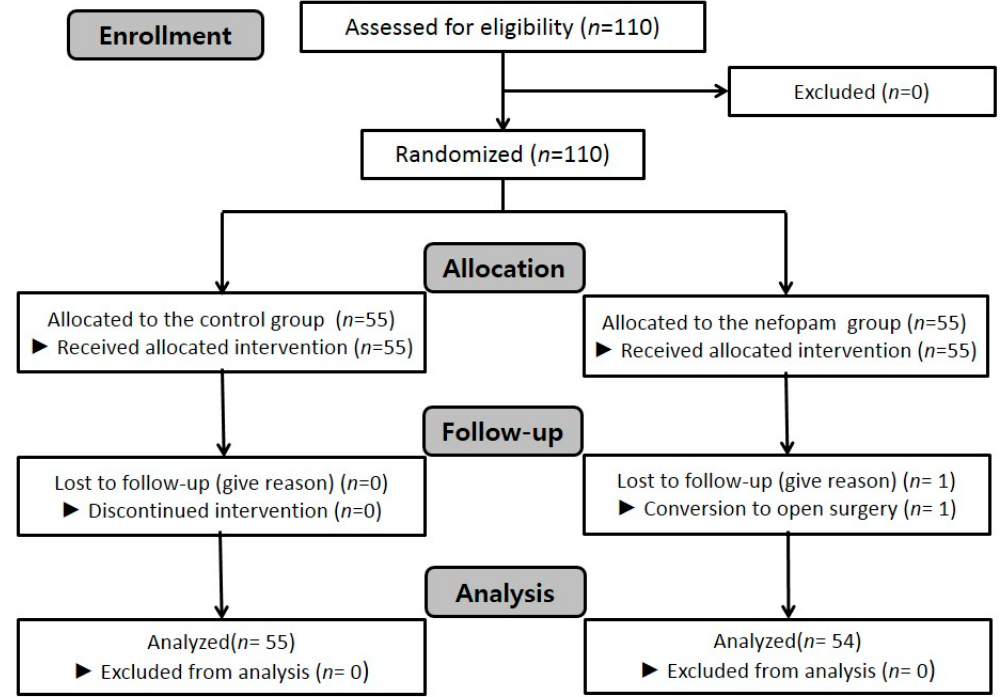
Figure 1. Flow chart of patient enrollment. Table 1. Demographic data.